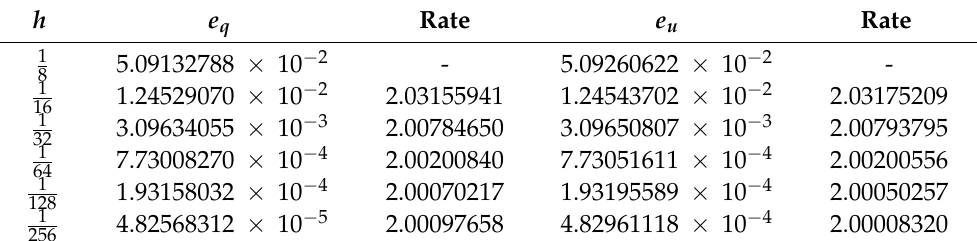
Table 1. Error e q and e u for the spatial convergence rates with α = 0.3.